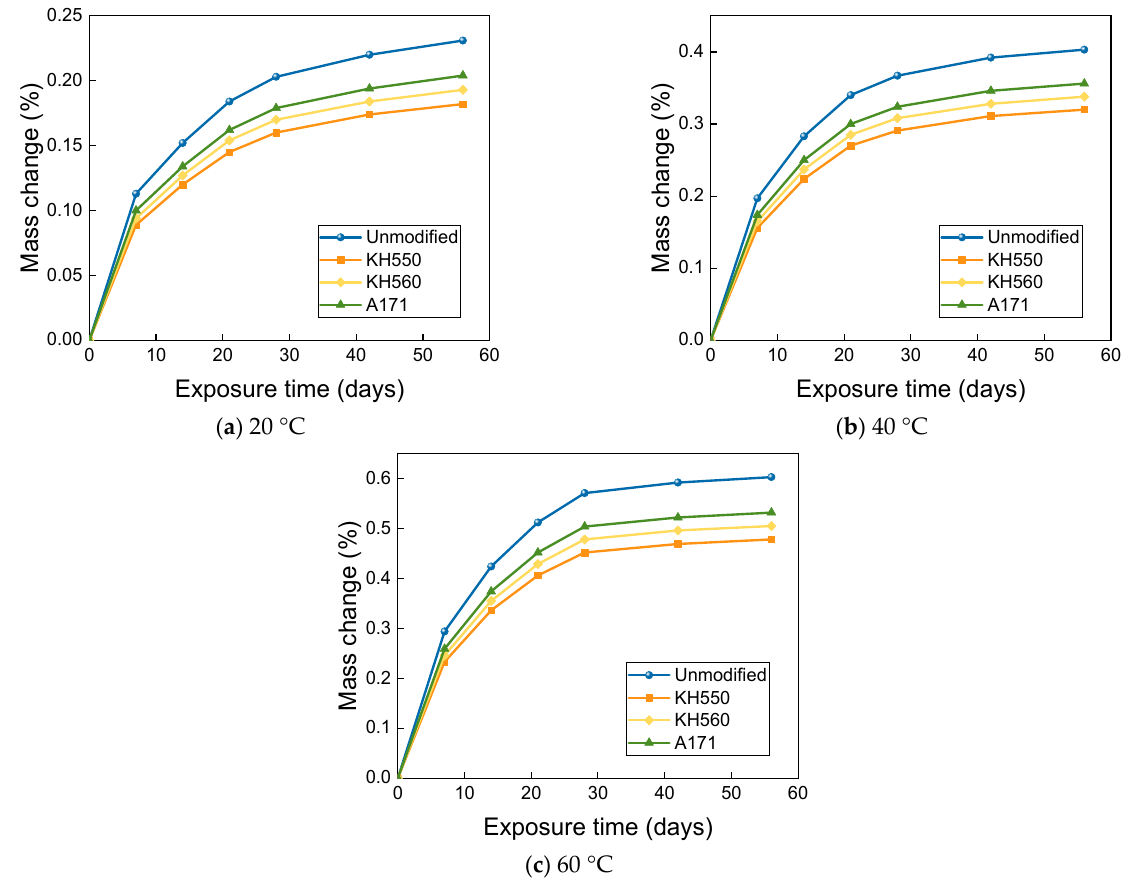
Figure 13. Mass change in a 3.5% NaCl seawater environment.